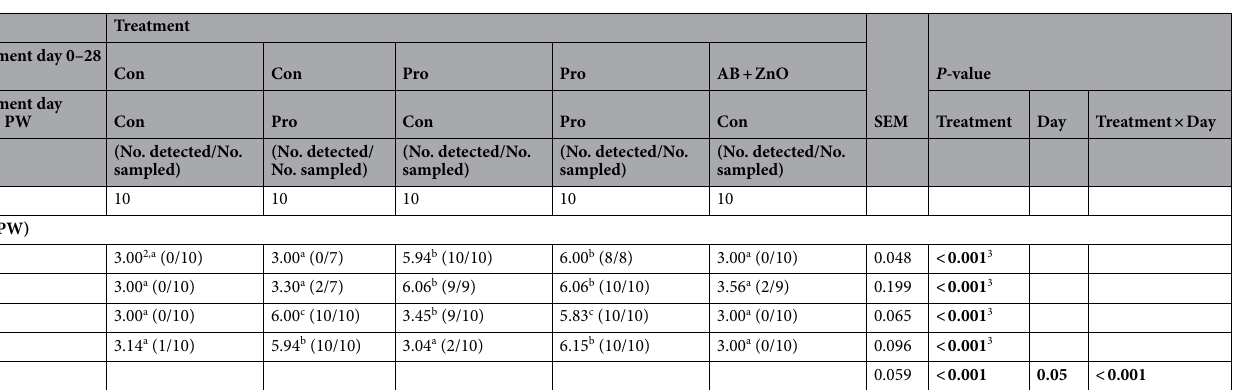
Table 3. Effect of Bacillus altitudinis WIT588 spore supplementation to 1st stage and/or 2nd stage weaner diets and antibiotic (AB) + ZnO supplementation to 1st stage weaner diets on faecal counts of B. altitudinis WIT588 (log 10 CFU/g) 1 at days 13, 27, 35 and 55 post-weaning. PW, post-weaning; Con, control; Pro, probiotic; AB + ZnO, antibiotic + zinc oxide. 1 Least square means and pooled standard errors of the mean (SEM). 2 The limit of detection of the assay for B. altitudinis WIT588 was 1000 CFU/g faeces. Values below